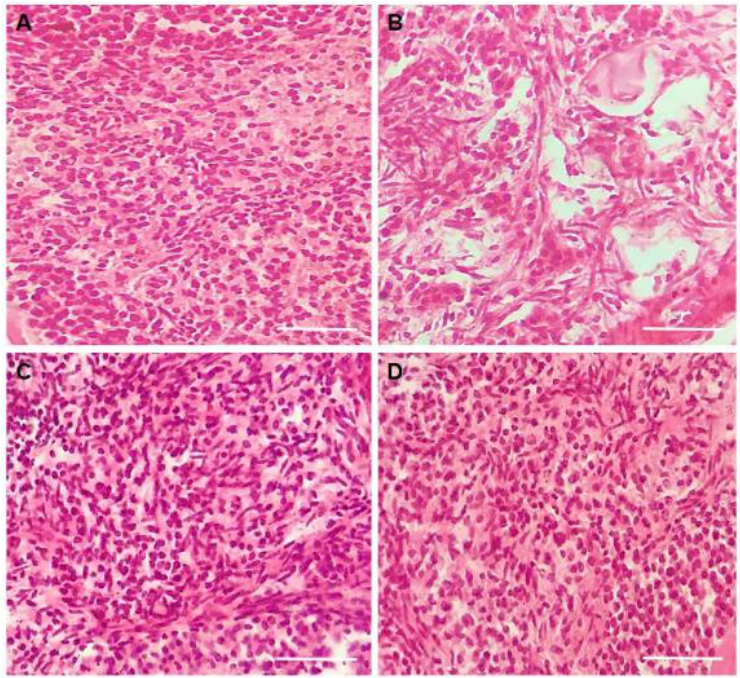
Figure 10. Representative images of ovarian stromal density after 6 days of culture: ( A ) control group (DMEM + ); ( B ) DOXO (0.3 μg /mL); ( C ) CIMI (5 ng/mL) and ( D ) CIMI (5 ng/mL) + DOXO (0.3 μg /mL). Scale bar: 100 μm (400 ×).